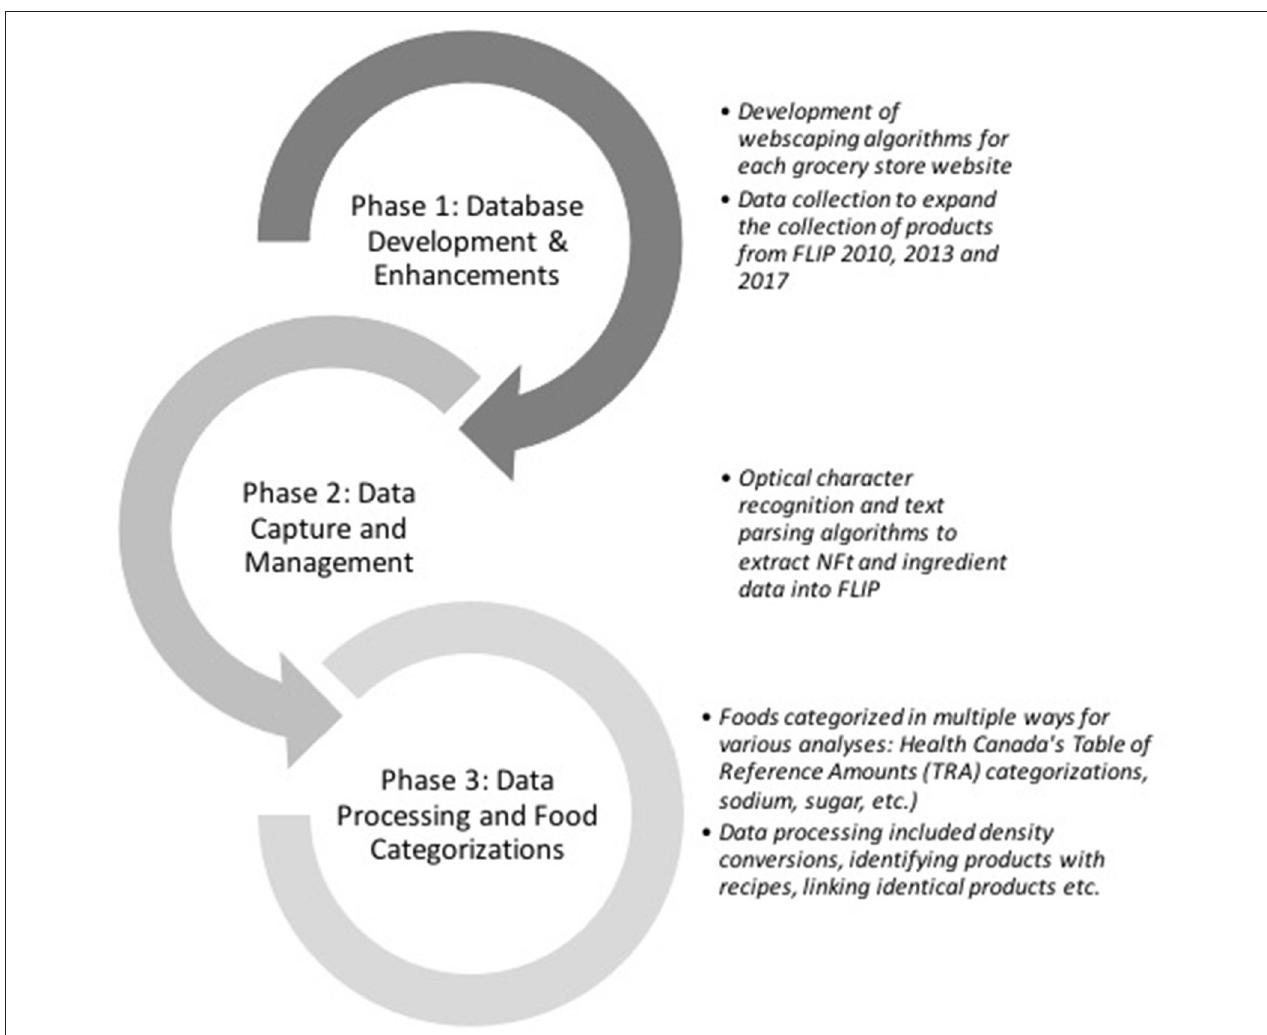
FIGURE 3 | Database development, data management and processing of FLIP 2020. *Product information included product images, serving size, price, nutrition information, and ingredient list. † For this phase, for the purpose of method development and reliability. FLIP, Food Label Information Program (FLIP); NFt; Nutrition facts